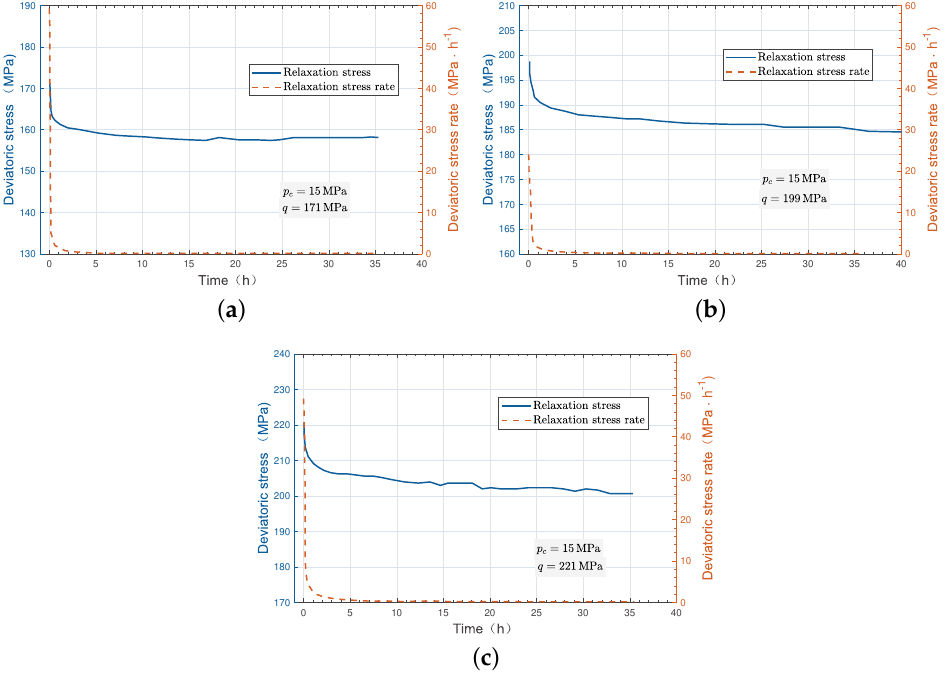
Figure 4. The single relaxation curves of Beishan granite under different levels of deviatoric stress with the confining pressure p c = 15 MPa. ( a ) q = 171 MPa; ( b ) q = 199 MPa; ( c ) q = 221 MPa. Table 2. Comparison of single-stage relaxation test results between Beishan granite. q